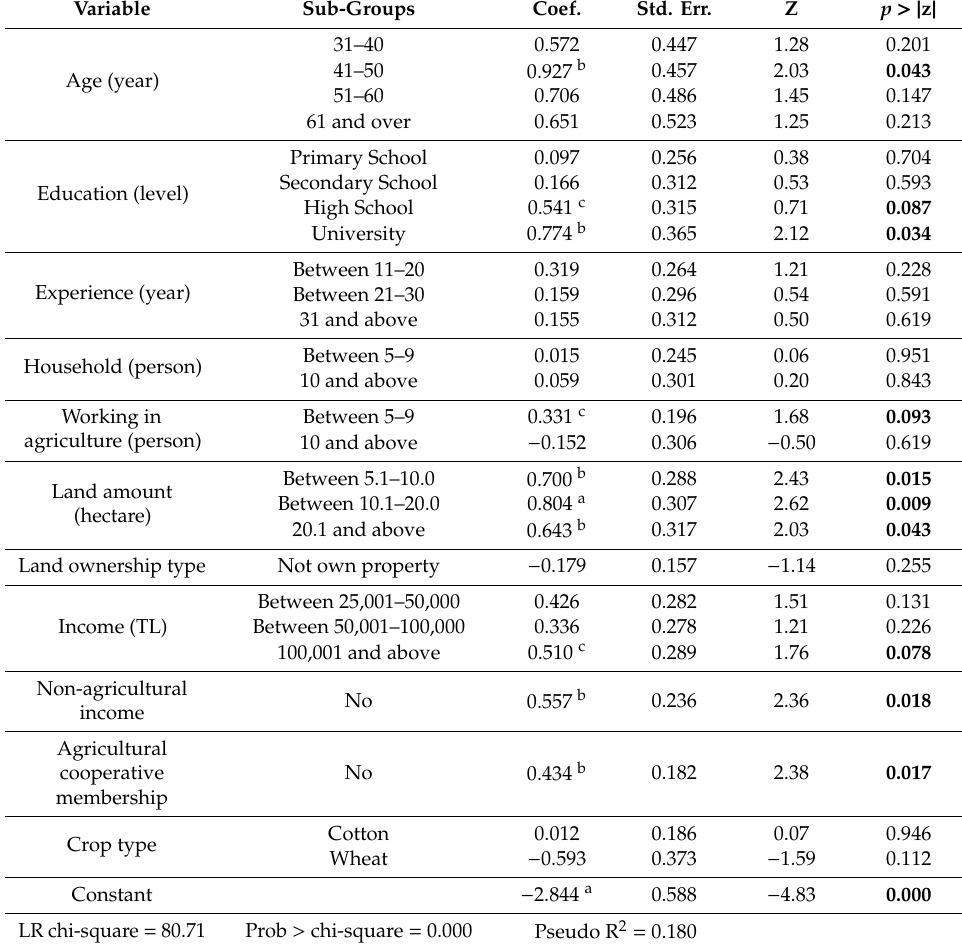
Table 3. Heckman’s first-stage model (Probit model / selection model) estimation